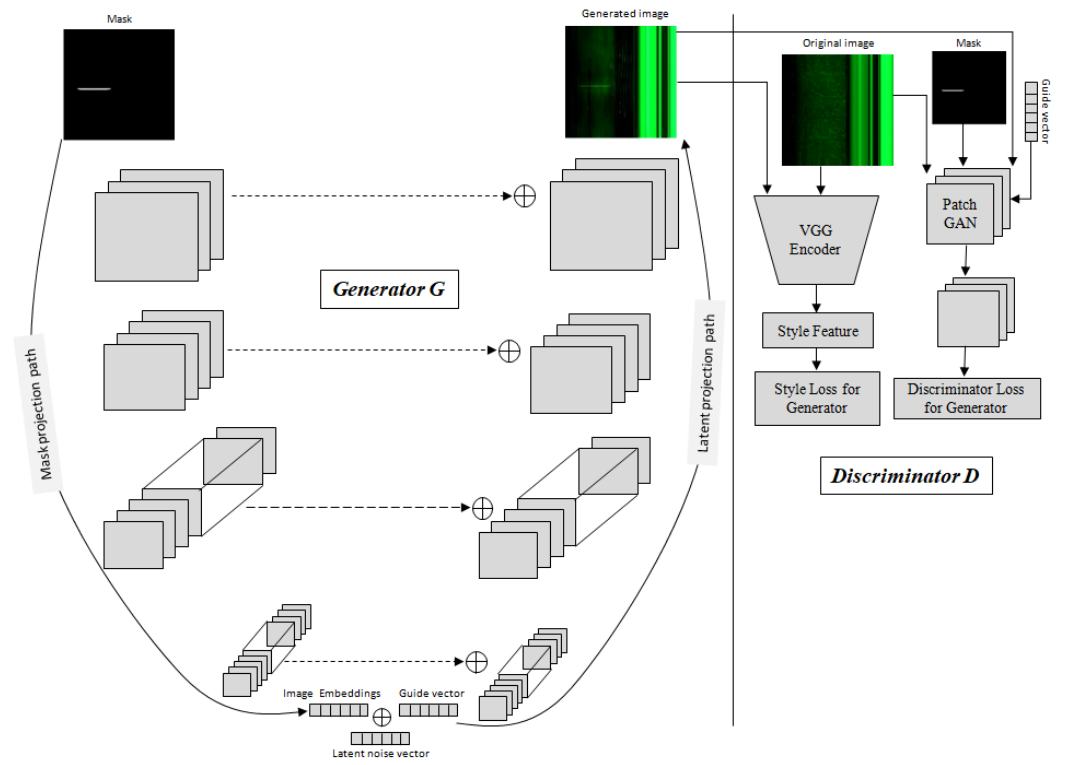
Figure 4. The Magna-Defect-GAN model comprises a U-net style generator network, a discriminator network, and a pretrained VGG feature extractor. The mask projection path in the Generator network G is tasked with mapping input masks into image embeddings through encoder blocks. The latent projection path is used to translate the combination of the image embeddings, guide vectors, and latent noise vectors into the output image. The discriminator network D is trained to distinguish real and generated images. The pretrained VGG network is used to extract features to calculate the style loss.